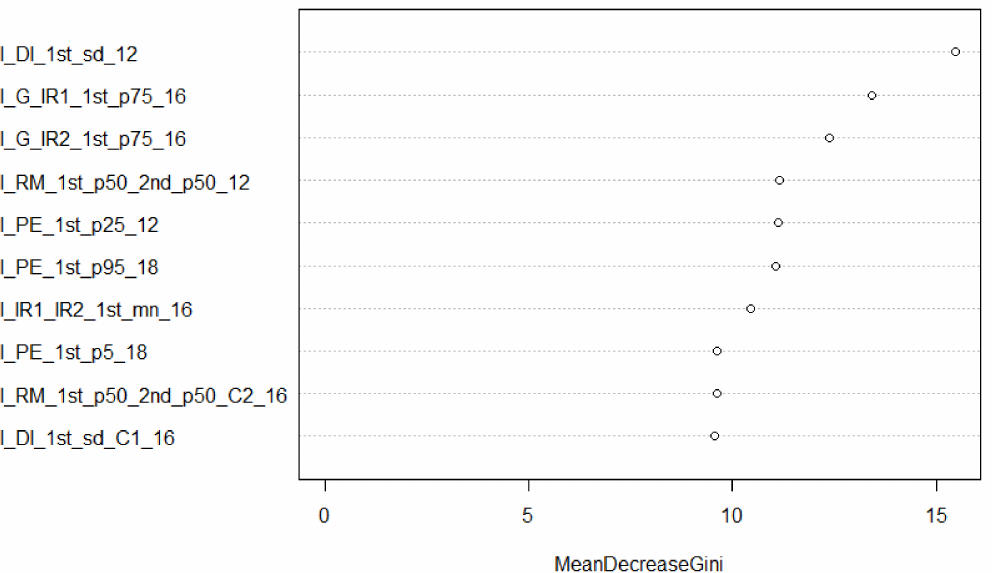
Figure 6. Mean Decrease Gini features for the 12- species classification (all sensors, top 10 I features only). The suffix after each feature (_12, _16, _18) refers to the dataset (ALS12, MSL16, SPL18) from which the feature was